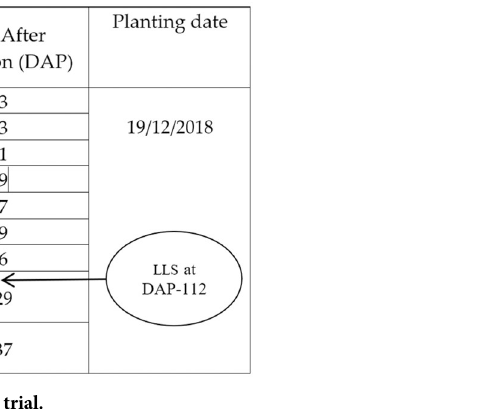
Fig 4. UAV images acquisition date of peanut